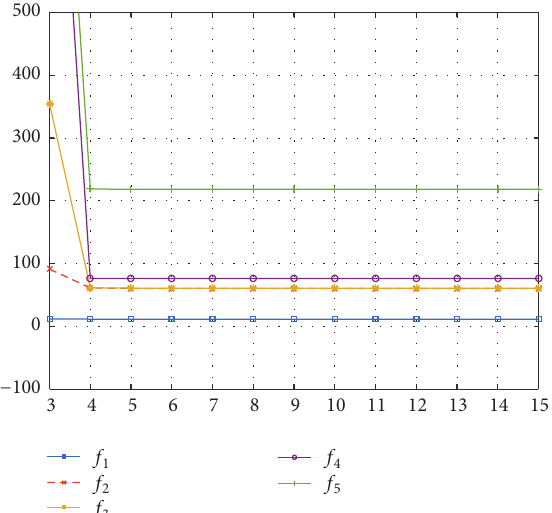
Figure 6: The convergence of the first five natural frequencies.